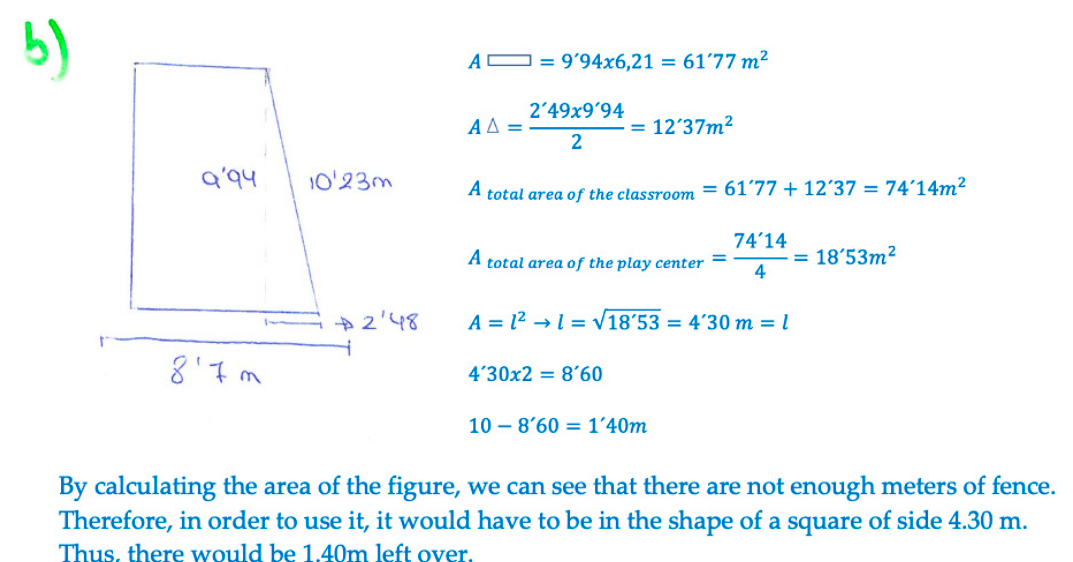
Figure A5. Translation into English of the written production for the task “the play center”. Answer to question b) (source: prepared by the authors).